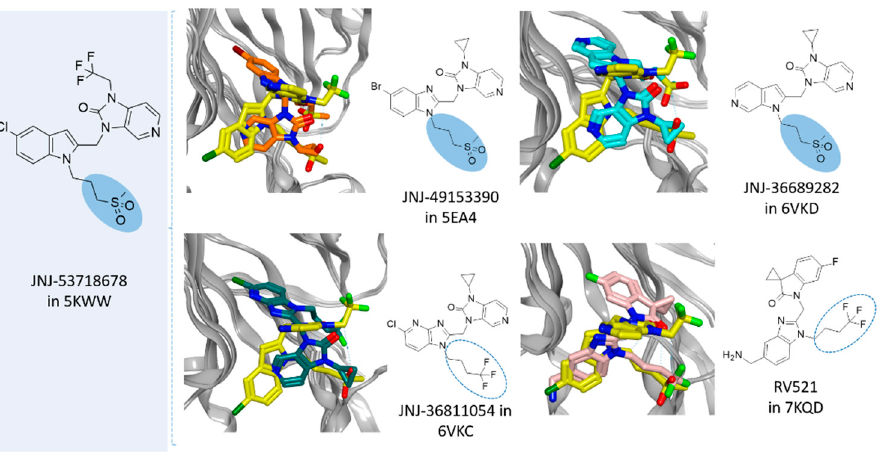
Figure 12. Comparison of the X-ray information about the JNJ-53718678 highly related analogues JNJ-49153390 (PDB code = 5EA4) [13], JNJ-36689282 (PDB code = 6VKD) [36], JNJ-36811054 (PDB code = 6VKC) [36], and RV521 (PDB code = 7KQD) [28] with the reference JNJ-53718678 (PDB code = 5KWW) [27]. The most recurrent conserved moieties and bioisostere substitutions are highlighted by light-blue circles and dot lines.